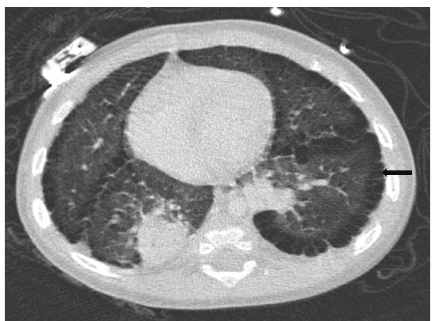
Figure 2: Axial view of chest CT shows the subpleural cysts (block arrow) of both lungs along the chest wall and the major